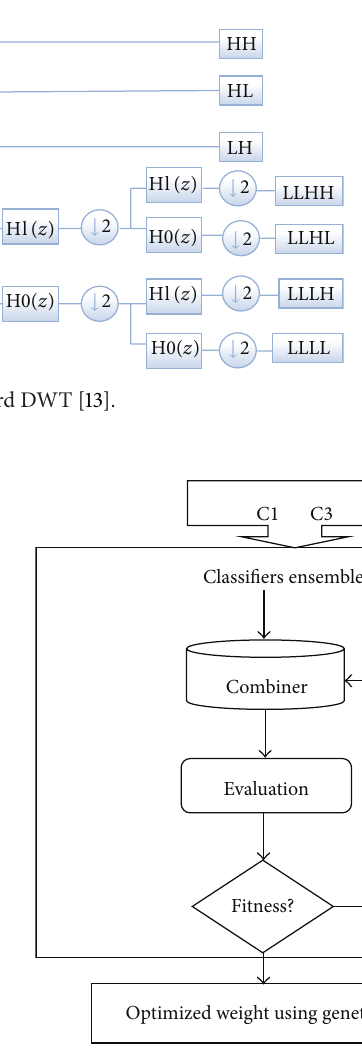
Figure 4: Classifiers ensemble and optimization process flow